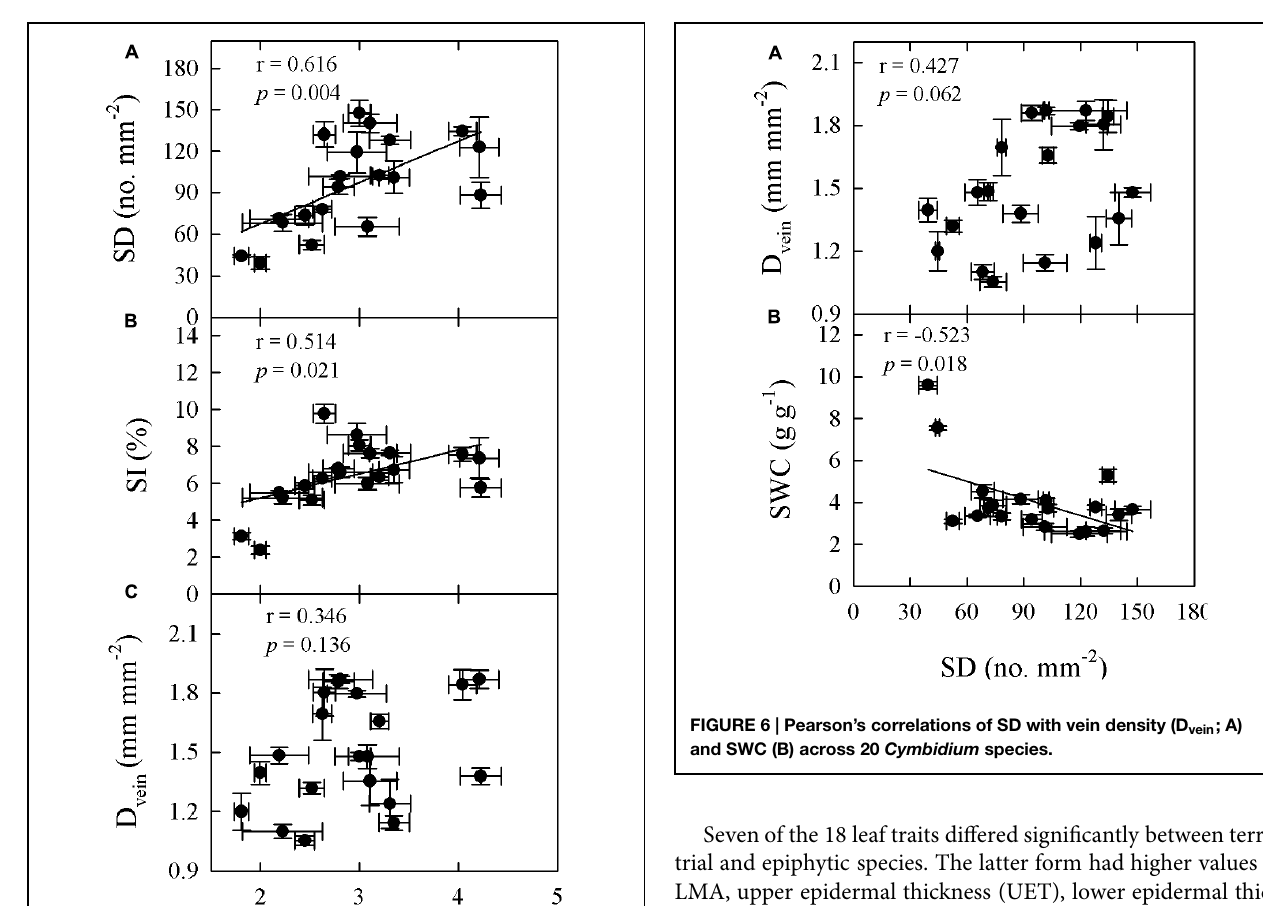
Seven of the 18 leaf traits differed significantly between terres- trial and epiphytic species. The latter form had higher values for LMA, upper epidermal thickness (UET), lower epidermal